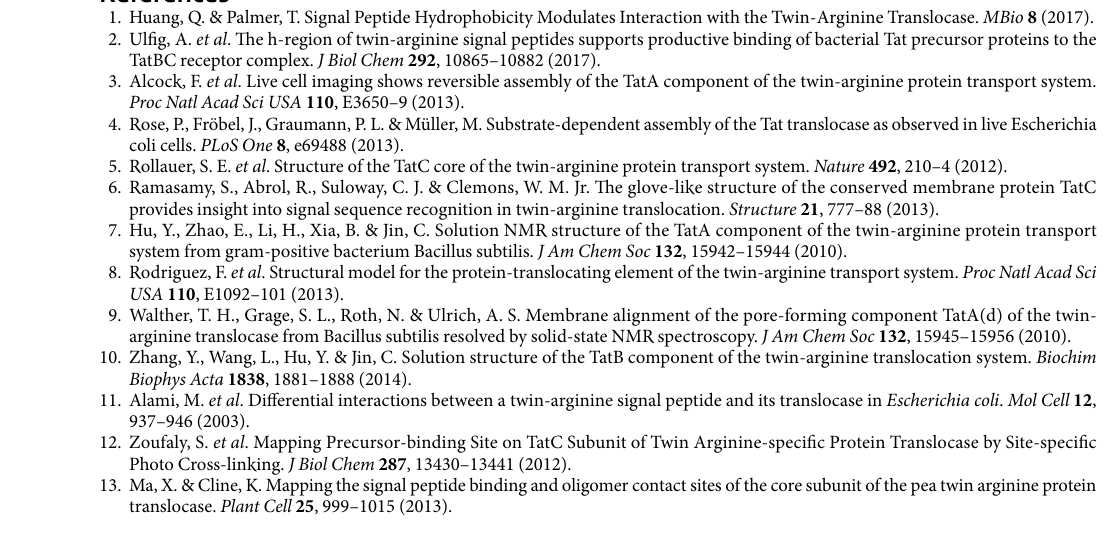
Inverted inner membrane